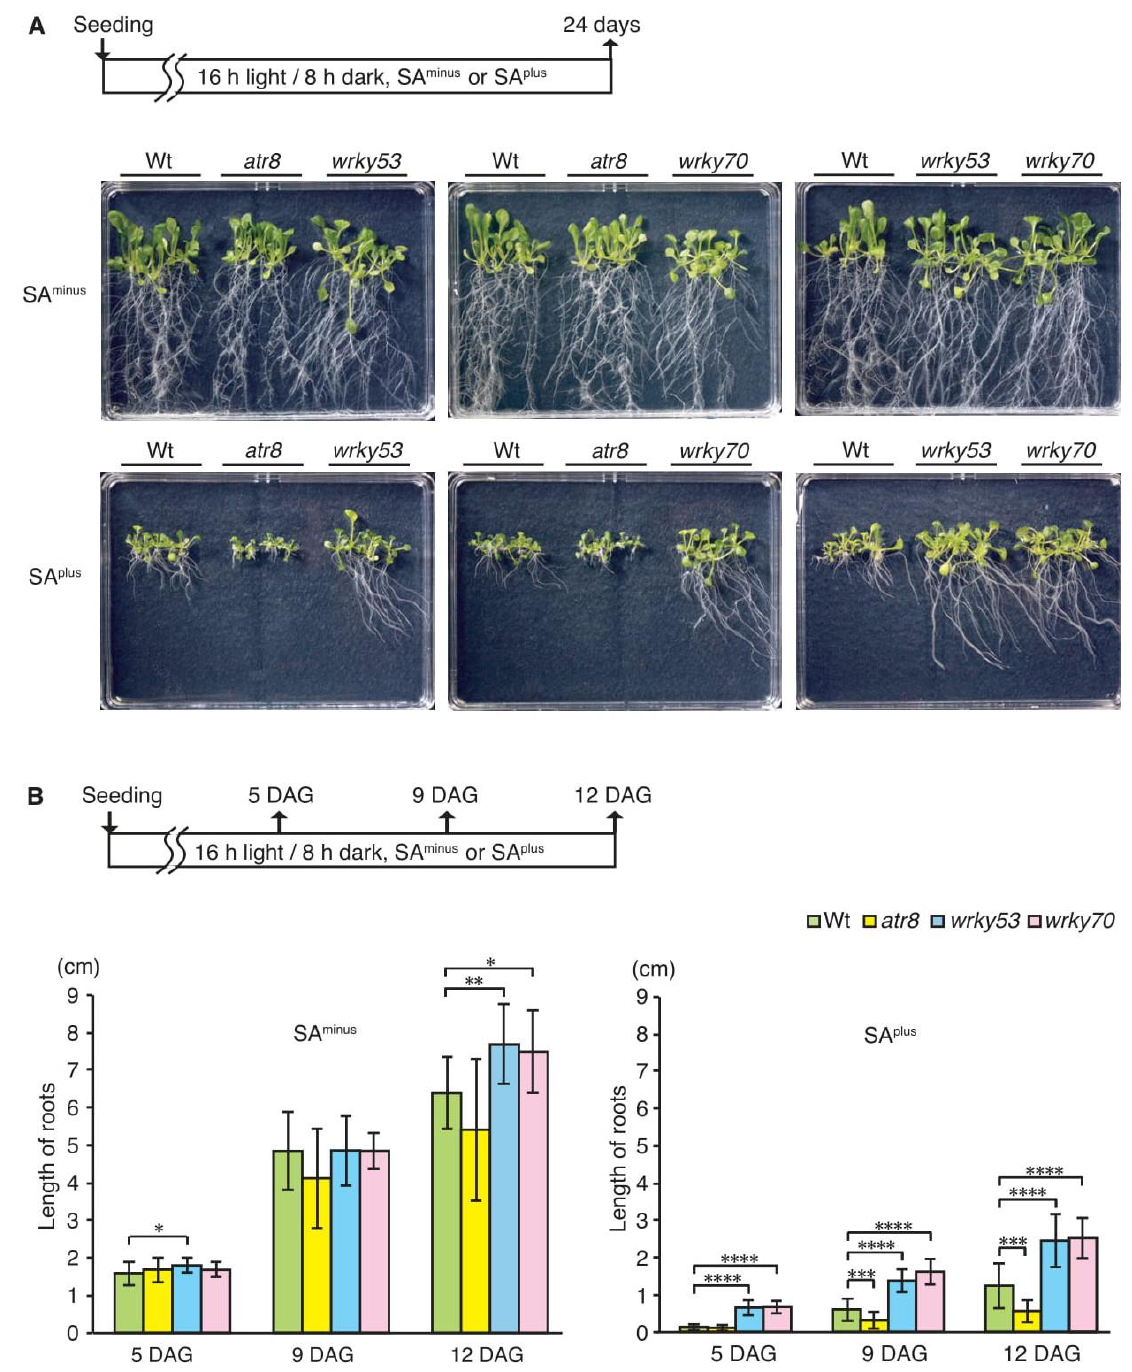
Figure 2. Inhibitory effects on the root elongation under lower salicylic acid (SA) conditions. ( A ) The root elongations of Arabidopsis seedlings were compared, which were grown on vertical 0.24% gellan gum medium with (SA plus ) or without (SA minus ) 20 µM SA for 24 days after seeding. To eliminate gellan gum plate-dependent difference, Wt and two out of the three mutant plants were combined with three individual plates. ( B ) The lengths of the primary root of (Supplemental Figure S2) was measured using ImageJ. Seedlings were grown ( A ) and root lengths were compared at 5, 9, and 12 days after germination (DAG). Bar graphs represent the mean values of more than 10 plants, and error bars represent ±SD. Significant differences in the lengths of the primary root between Wt and each of the mutants are indicated as * p < 0.05, ** p < 0.01, *** p < 0.001, and **** p < 0.0001 (Welch ’ s t -test).